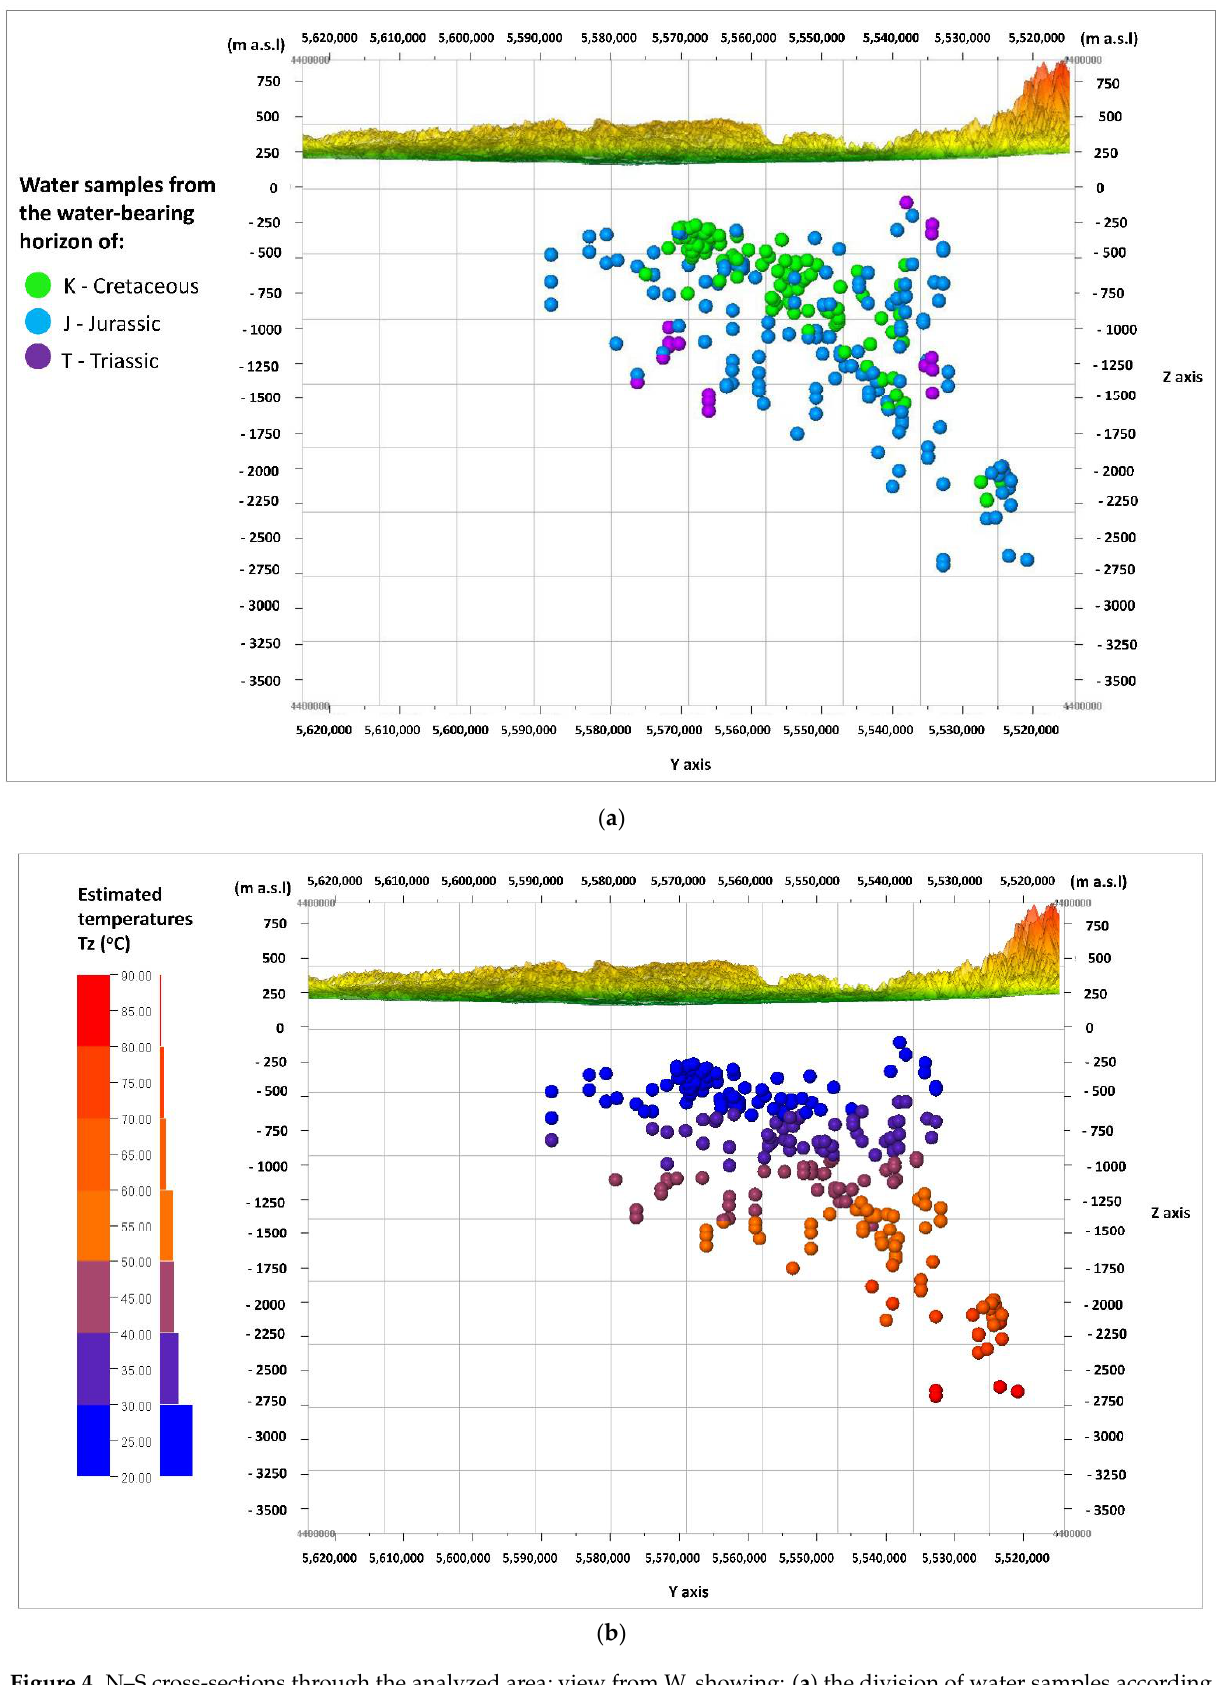
Figure 4. N–S cross-sections through the analyzed area; view from W, showing: ( a ) the division of water samples according to their origin from the Cretaceous (K), Jurassic (J), or Triassic (T) aquifers; ( b ) the distribution of the estimated depth temperatures